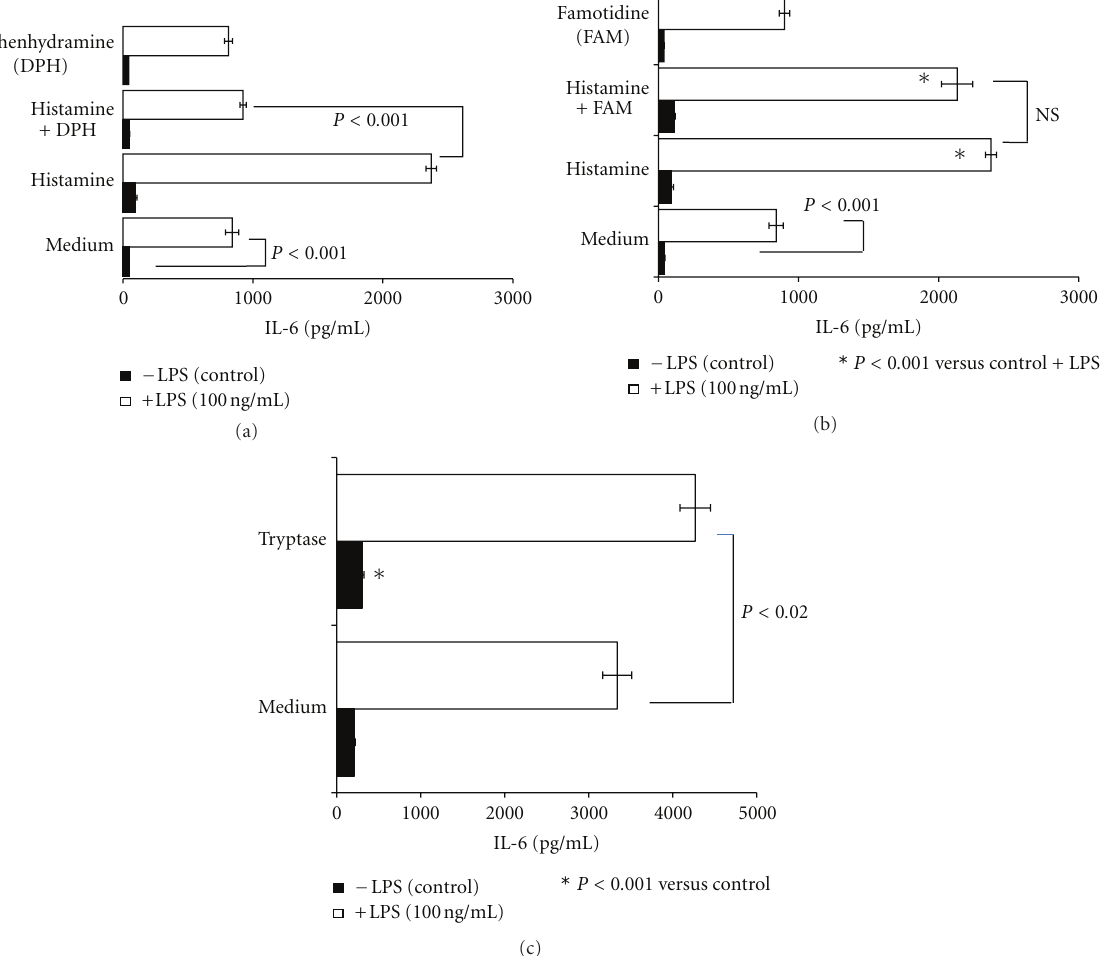
Figure 5: Histamine and Tryptase induce potentiation of IL-6 production by LPS-stimulated endothelial cells. Endothelial cells (10,000cells/well) were incubated with histamine (10 μ M) (a and b) or human tryptase (50mU/mL) (c) in the presence or absence of LPS (100ng/ml) for 24 h. After the incubation, culture supernatants were analyzed for IL-6 by ELISA. To determine the e ff ect of H1R or H2R antagonists, endothelial cells were incubated with 10 μ M diphenhydramine (DPH) (a) or 10 μ M famotidine (FAM) (b) for 30 min before addition of histamine. Results are mean ± SEM of quadruplicate determinations of a representative experiment. Similar results were observed in two other